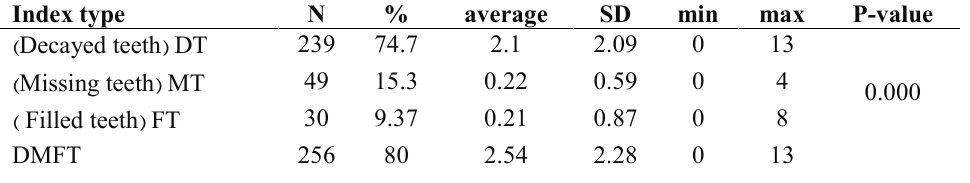
Table 2 the components of DMFT among students in Piranshahr